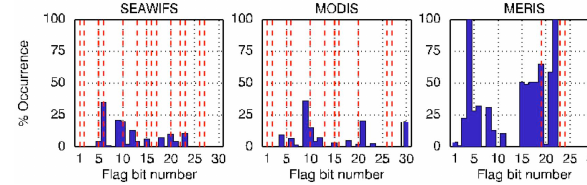
Fig. 5. Statistical occurrence of the L2 flags within NoFlags matchup files for SeaWiFS (left), MODIS (middle) and MERIS (right), whose statistics are shown in brackets in Table 4. Ver- tical dashed lines indicate the flags operationally activated for the standard processing. For a complete description of the phys- ical meaning of the flag bit numbers, the reader should refer to http://oceancolor.gsfc.nasa.gov/VALIDATION/flags.html for Sea- WiFS and MODIS, and to http://earth.eo.esa.int/pcs/envisat/meris/ documentation/meris 3rd reproc/Vol11 Meris 6a.pdf for